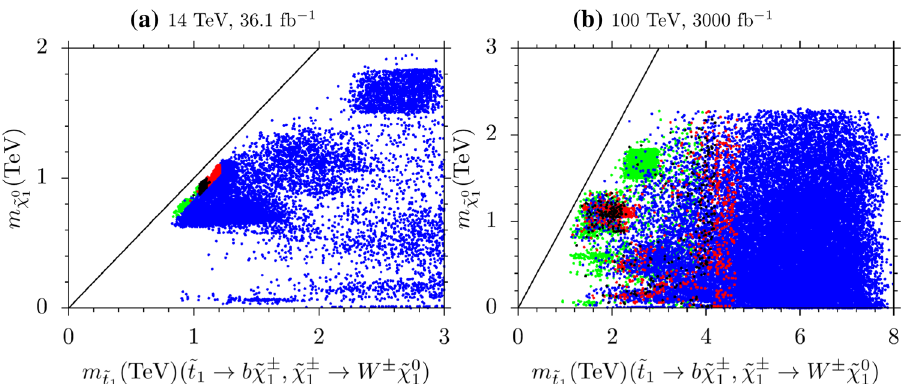
− 1 lumi- − m ˜ Fig. 8 Plots in the m ˜ χ 0 decays. Blue points represent the solutions with SS ( Signal 2 ) < 1, t 1 plane at 14 TeV with 36.1 fb 1 while red and black correspond to 1 ≤ SS ( Signal 2 ) ≤ 2, and nosity (left), and 100 TeV with 3000 fb − 1 luminosity (right). All solu- 2 ≤ SS ( Signal 2 ) ≤ 3, respectively. The green points yield SS > 3 tions satisfy the mass bounds and the constraints from rare B − meson